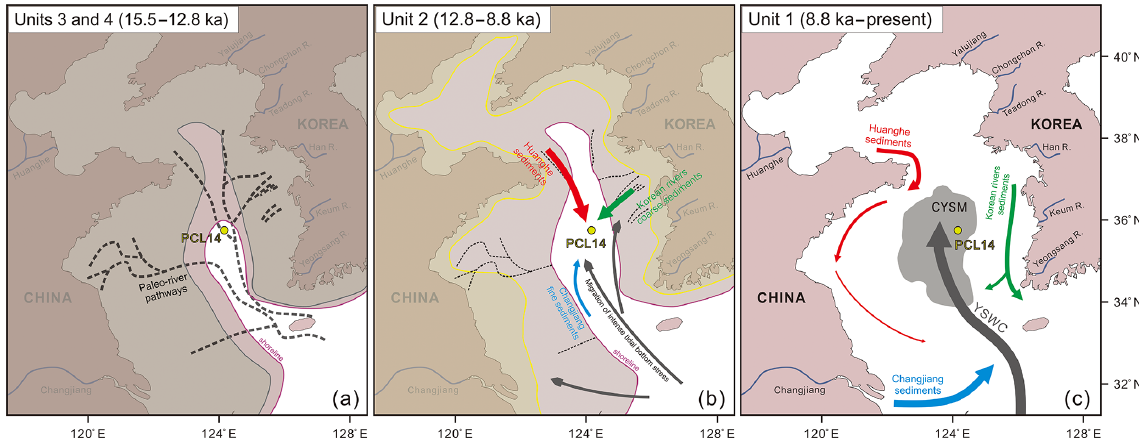
Figure 7. Schematic diagram showing the influence of shoreline changes and paleo-river pathways on riverine sediment supplied to the study area during (a) Unit 4 and 3 (15.5–12.8ka), (b) Unit 2 (12.8–8.8ka), and (c) Unit 1 (8.8ka–present) (modified Lim et al.,